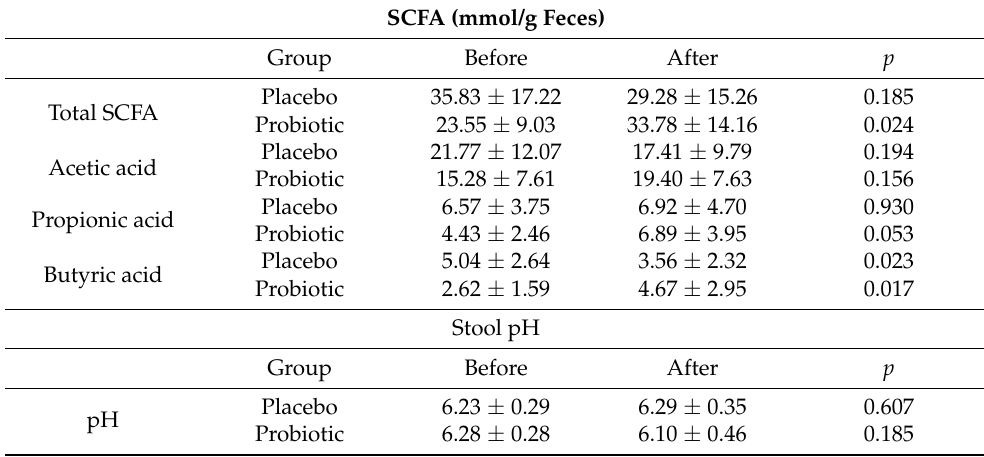
Table 7. The changes of the SCFA concentration and stool pH between the groups after the